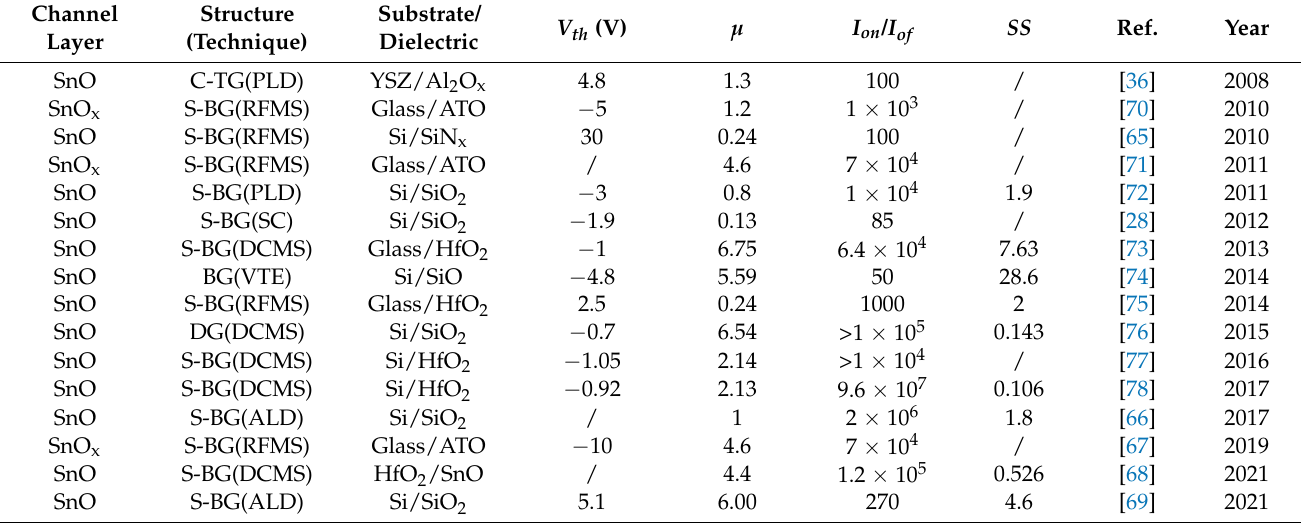
Table 2. The performance of SnO x -based p-Type Thin-Film